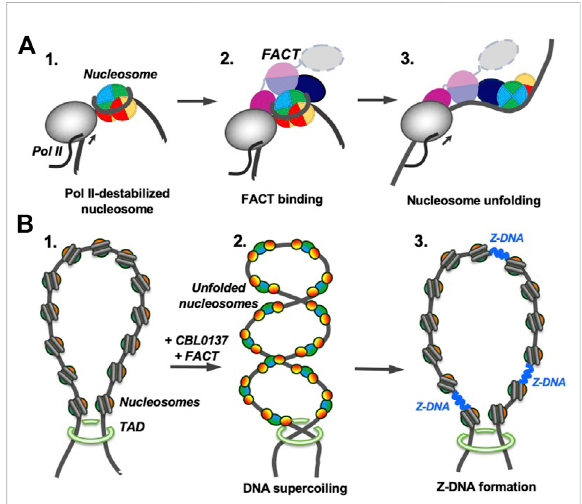
Possible functions of FACT-induced nucleosome unfolding. The color code as in Figure 7. (A) FACT-dependent nucleosome unfolding during transcription by Pol II. Transcribing RNA polymerase II (Pol II) partially uncoils nucleosomal DNA from thehistone octamerand opensFACT-interacting surfaces ofH2A/ H2B dimers (intermediate 1) (Kulaeva et al., 2009). FACT binds to the destabilized nucleosomes (intermediate 2) and induces nucleosome unfolding (intermediate 3) that could facilitate further transcription and nucleosome survival during this process. (B) Curaxin-dependent Z-DNA formation. As curaxins and FACT interact with nucleosomes in a chromatin region, that is, closed by topologically associating domains (TADs, structure 1), bulk nucleosomes are unfolded, releasing unconstrained DNA supercoiling (intermediate 2). DNA supercoiling, in turn, induces formation of Z-DNA (intermediate 3) that could serve as a trigger ofnecroptosisincancercells(Sa fi